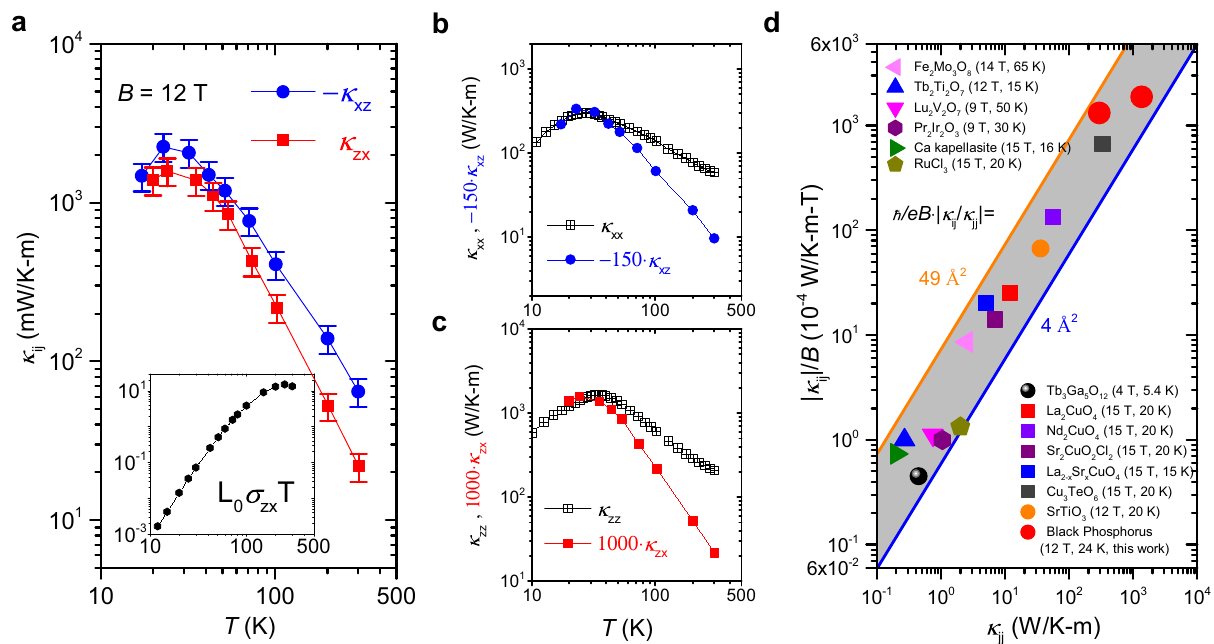
Fig. 2 | Thermal Hall conductivity. a Temperature dependence of the measured off-diagonal thermal conductivities, κ zx and − κ xz . At low temperature, they become equaltoeachotherwithinexperimentalmargin,asexpectedbyOnsagerreciprocity. With warming towards room temperature a difference arises, presumably due to non-negligible contribution of the thermoelectric response to transverse heat fl ow. b Comparison of the temperature dependence of κ xz , multiplied by − 150 and κ xx . c Comparison of the temperature dependence of κ zx , multiplied by 1000 and κ zz .